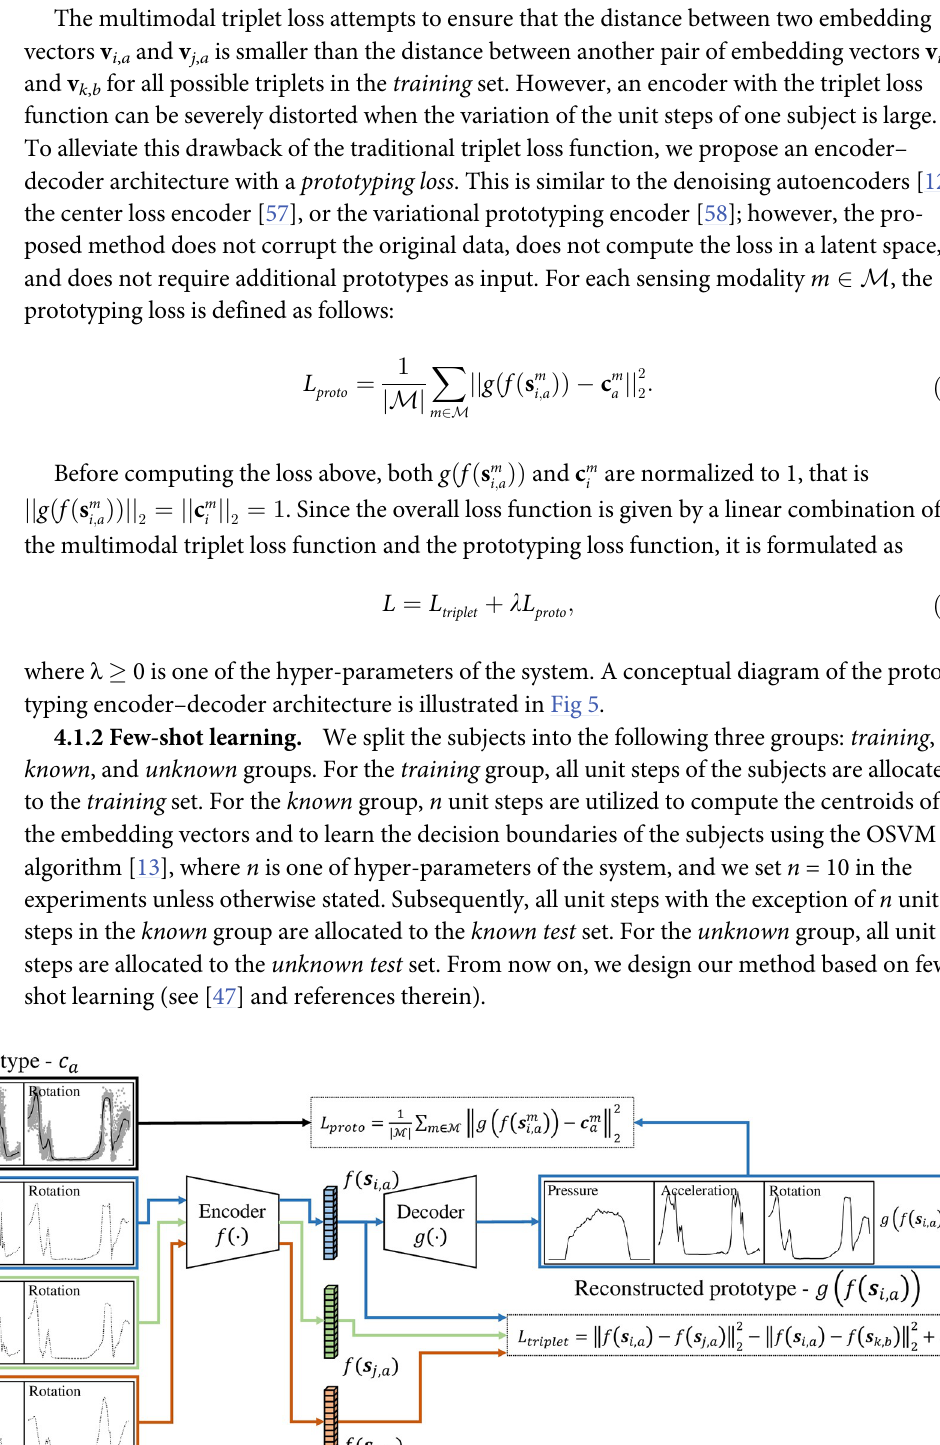
PLOS ONE | https://doi.org/10.1371/journal.pone.0264783 March 11,